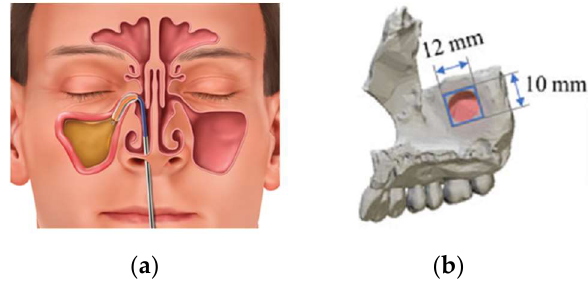
Figure 1. Maxillary sinus position: ( a ) front view and ( b ) left view.